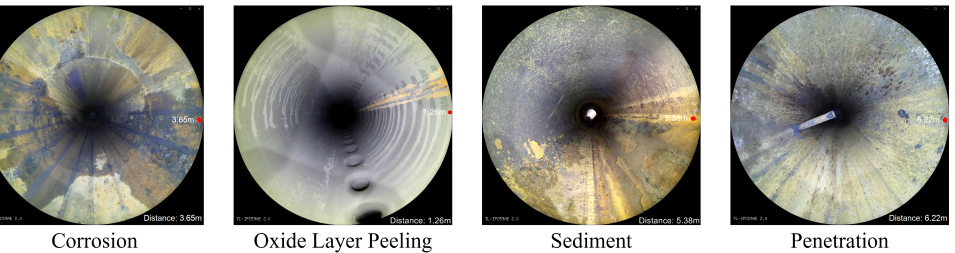
Figure 6. Examples of different defect